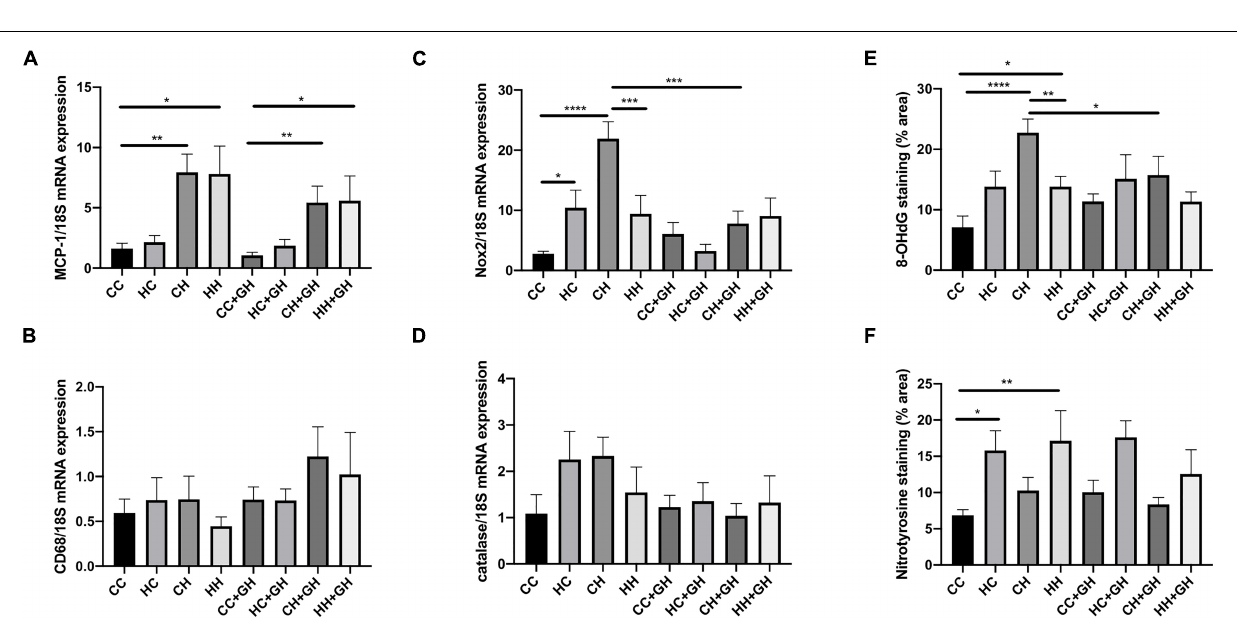
Frontiers in Cell and Developmental Biology |